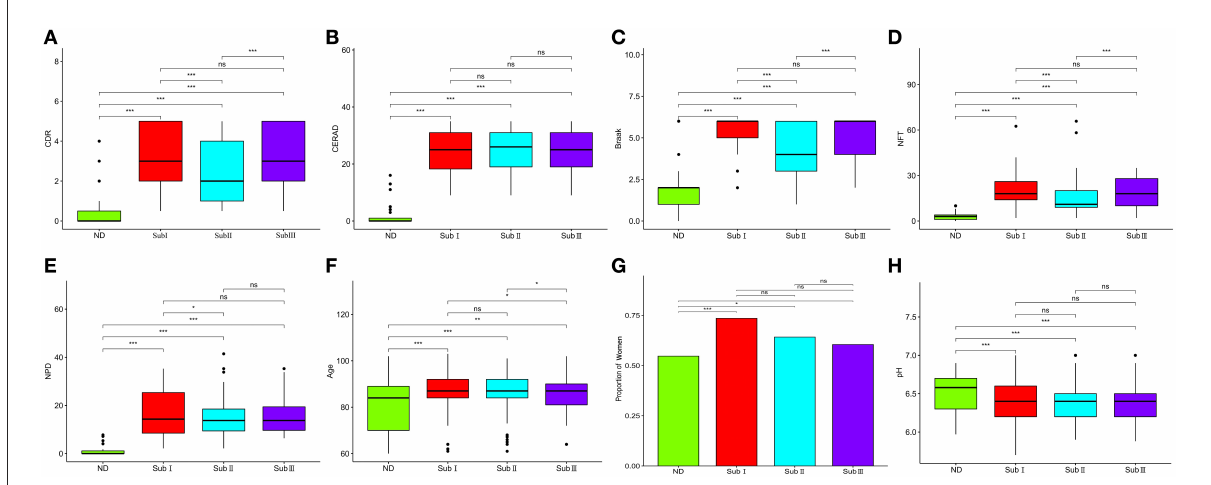
FIGURE5 Clinical characteristics of subgroups. (A) Comparison of CDR between each group. (B) Comparison of Braak between each group. (C) Comparison of NFT between each group. (D) Comparison of CERAD between each group. (E) Comparison of NPD between each group. (F) Comparison of pH between each group. (G) Proportion of women. (H) The proportion of women in each subgroup and ND group. ND, n = 456–497; Sub I, n = 202–223; Sub II, n = 368–391; Sub III, n = 120–129. Wilcoxon’s rank-sum test, ns P > 0.05; * P < 0.05; ** P < 0.01; *** P < 0.001.